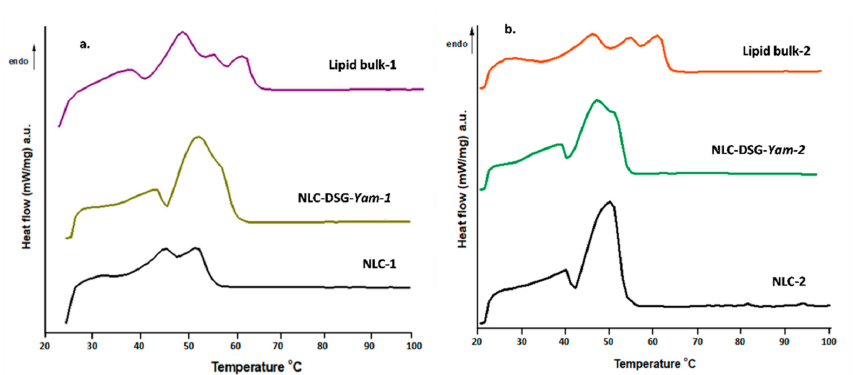
Figure 4. Comparison between DSC curves of bulk lipids, free-nanocarriers and nanocarriers loaded with DSG and Yam , with EPO ( a ) and SOY ( b ).